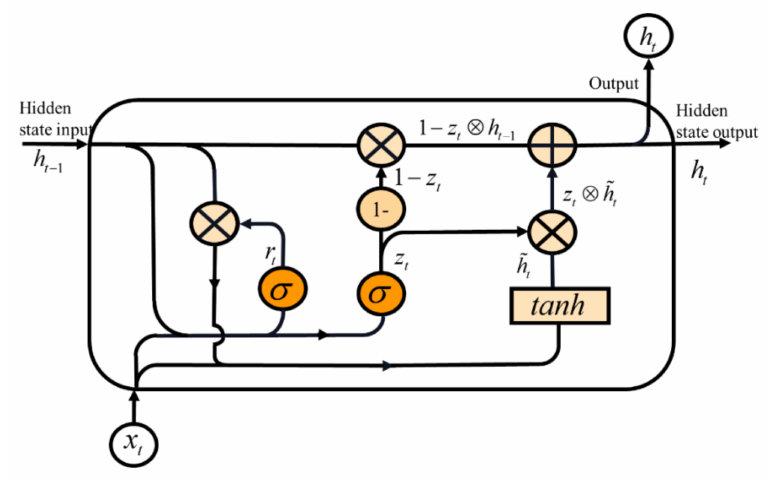
Figure 2. GRU structure diagram.